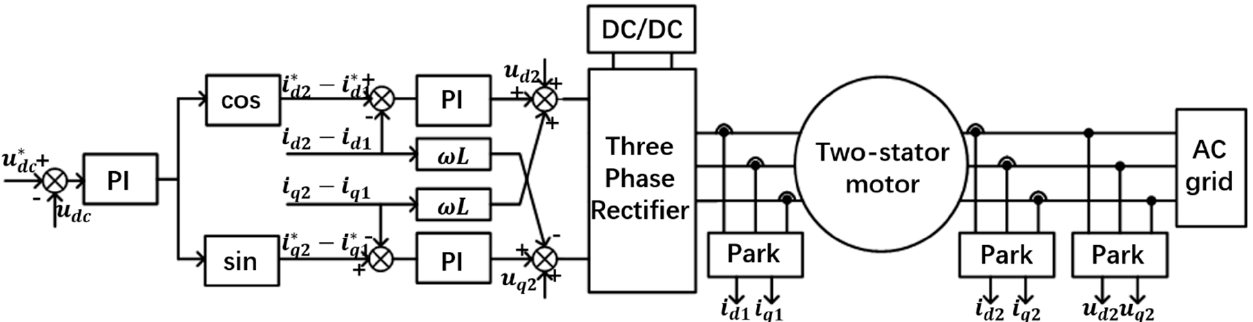
Figure 7. Control model of two-stator HEPMSM in driving mode.